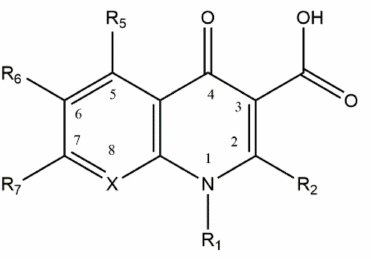
Figure 1. Structure of the base nucleus of quinolones and naphthyridones, drawn using ChemDraw Professional 17.0. The position 8 is occupied by a carbon or a nitrogen atom (substituted or non- substituted), in the case of quinolones or naphthyridones,